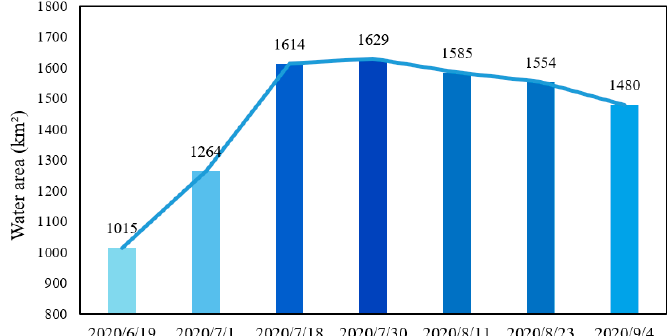
Figure 17. The water area changes of the East Dongting Lake.